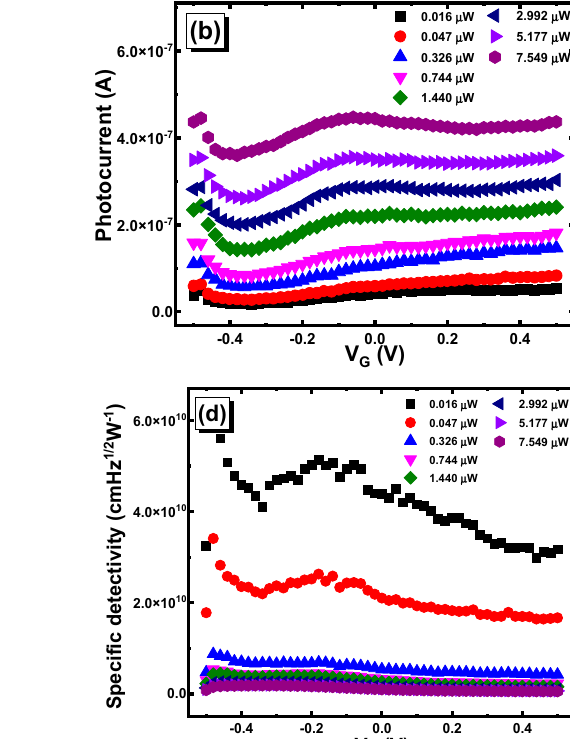
Figure 6. Polarization voltage and laser power dependence in Gr/n-MoSe 2 heterojunction: ( a ) Out- put characteristics (I ds –V ds or I 12 –V 12 ), ( b ) photocurrent, ( c ) photoresponsivity, and ( d ) specific detec- tivity at gate voltage (V G or V 3 ) of 0.5 V.